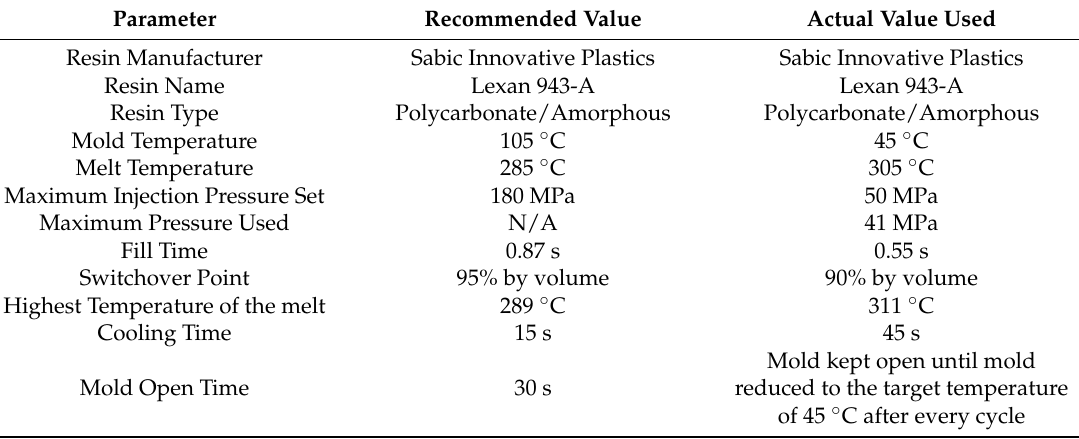
Figure 4. Core and cavity insert. Table 3. Process parameters recommended vs used for case study 2.